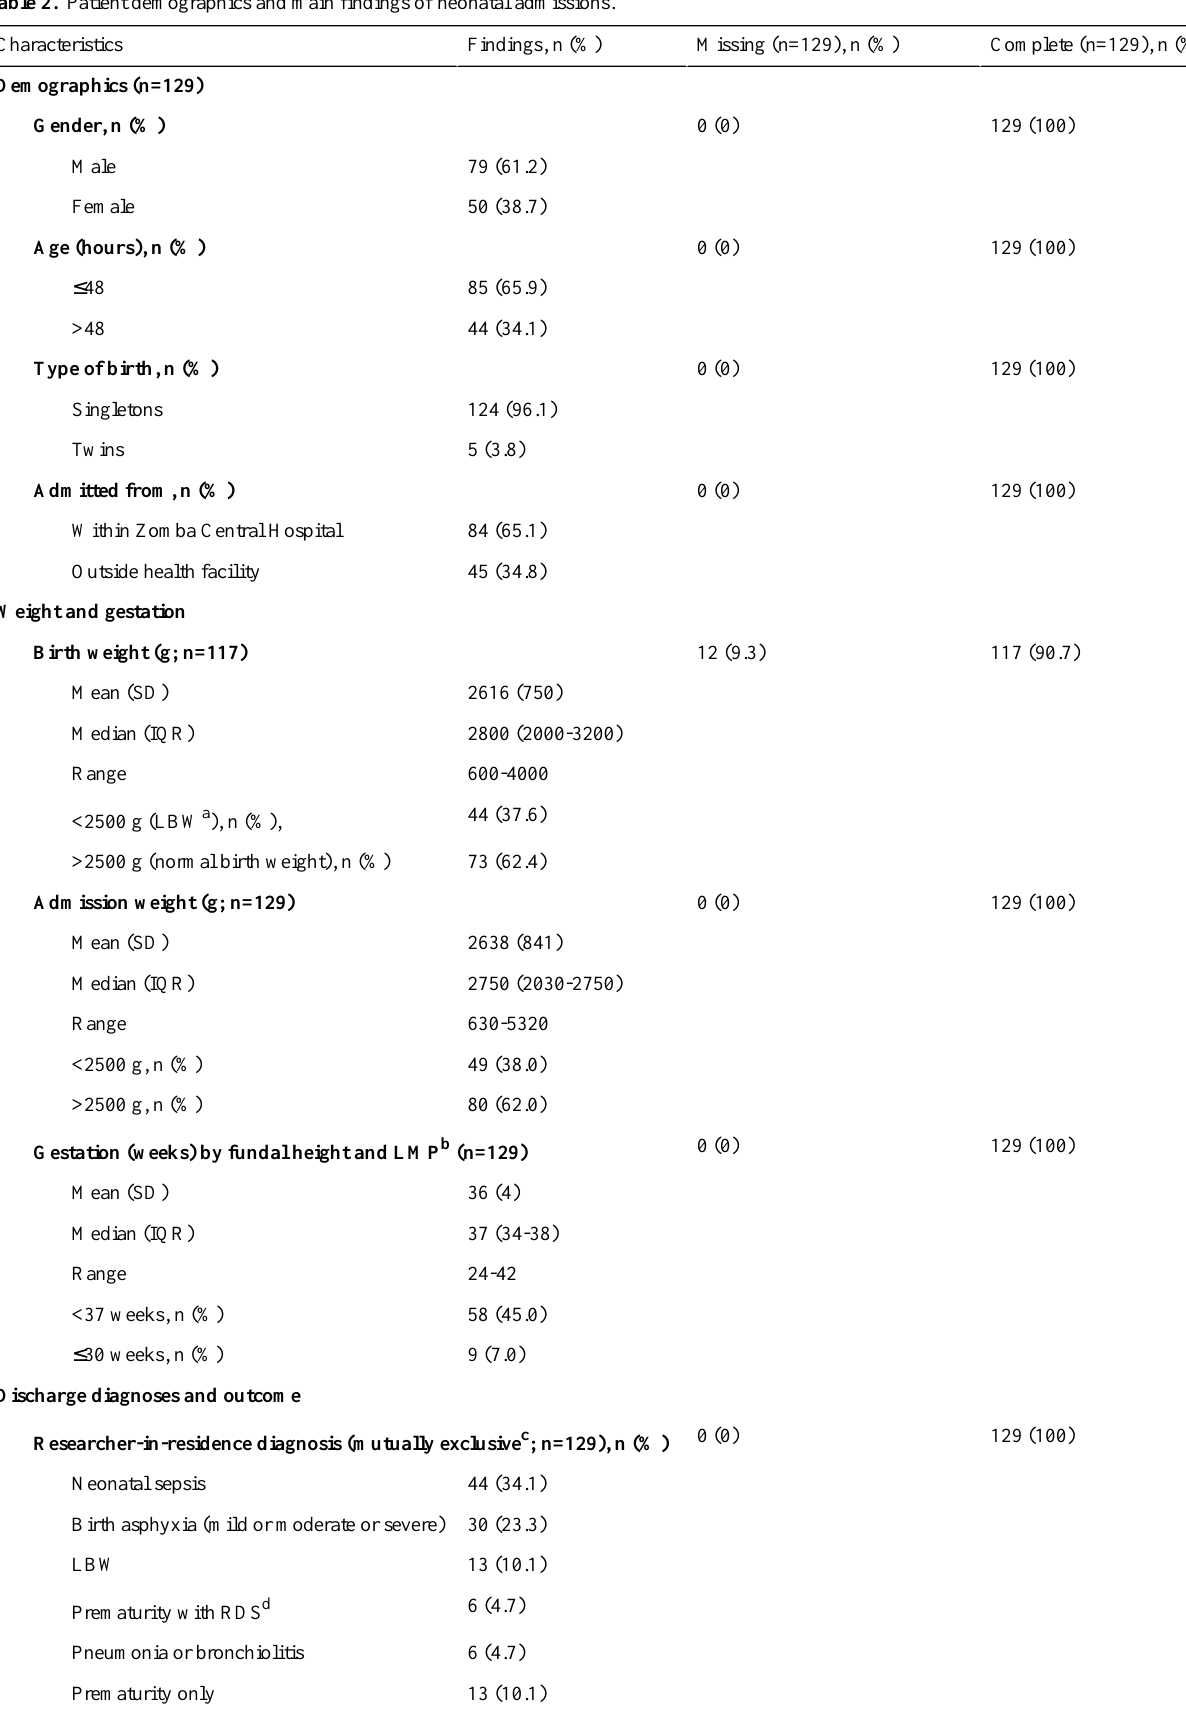
Table 2. Patient demographics and main findings of neonatal